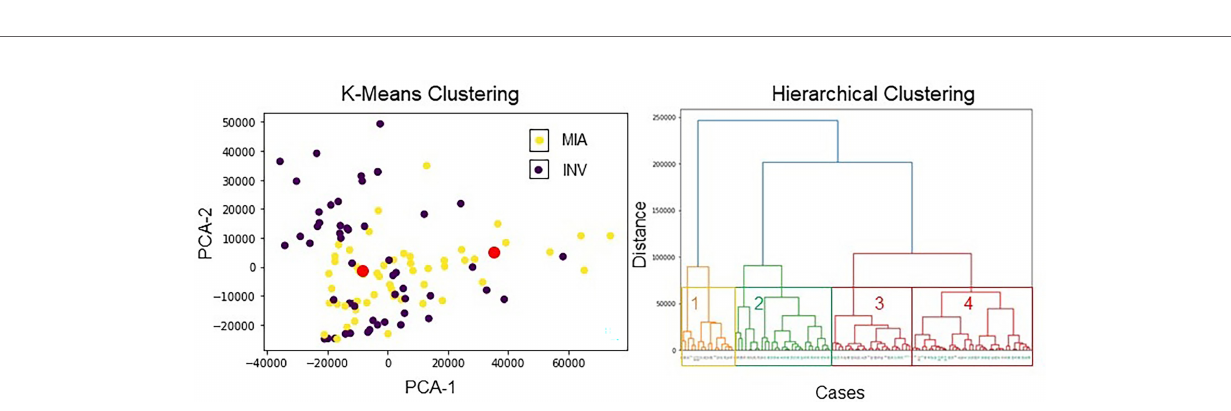
FIGURE 4 | Unsupervised clustering analysis using radiomic features. (left image) K-means clustering with 4 clusters. The red dots show the centroids of the three clusters obtained via K-means clustering. The violet points represent INV patients, and the yellow points depict MIA patients. The two distinct clusters had an accuracy of 73.13% to distinguish MIA from INV cases. (right image) Hierarchical clustering using all features. On the x-axis, black color stands for the INV cases, and aquamarine color stands for the MIA